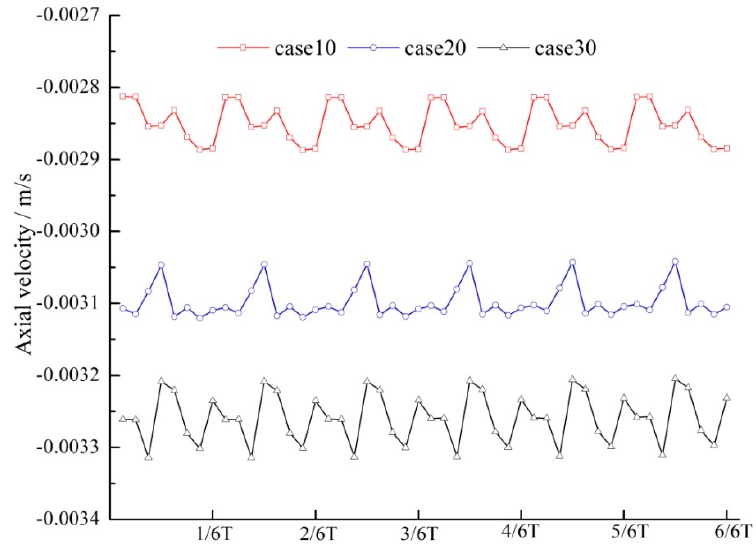
Figure 9. Evolution of the area-weighted average axial velocities in one impeller revolution.